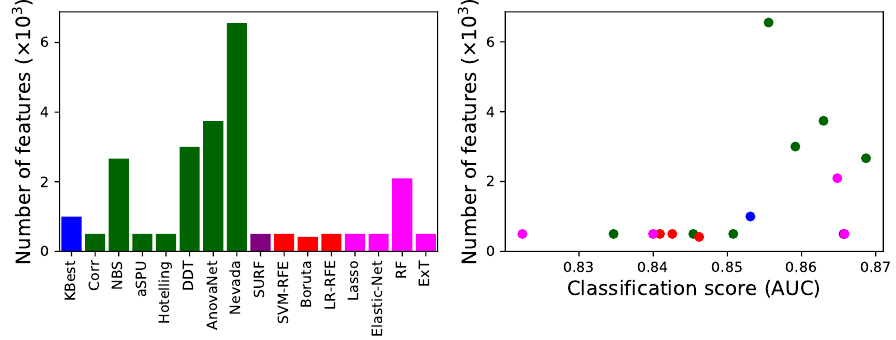
Figure 3. ( Left ) Number of features retained by each method (excluding the three underperforming ones), in thousands. ( Right ) Number of retained features as a function of the score (AUC) achieved by each method. The colour of each method corresponds to the one in Figure